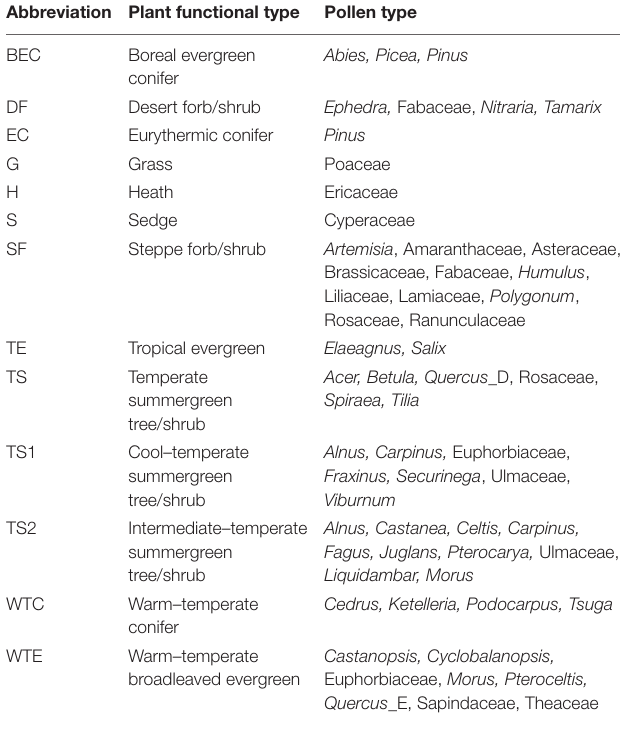
TABLE 2 | Assignment of the pollen taxa from Daye Lake to plant functional types (PFTs) used in the biomization model. Abbreviation Plant functional type Pollen type